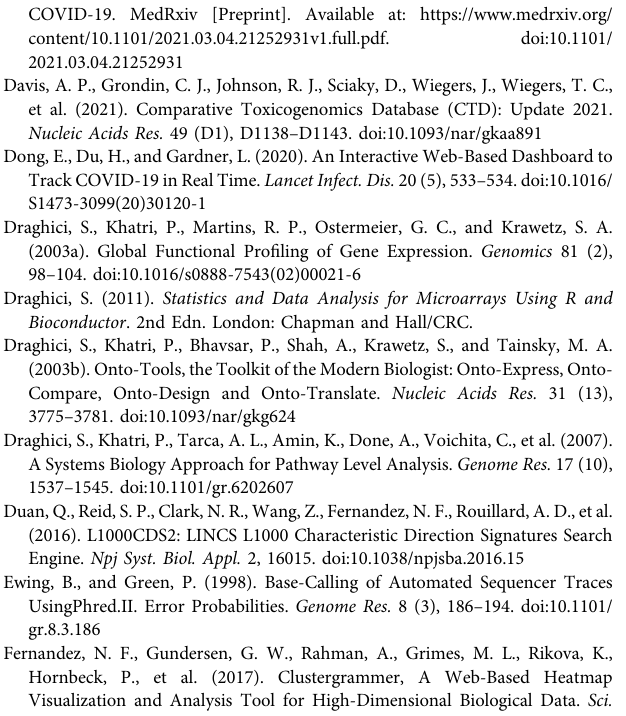
Downregulated, and Upregulated) by JQ1 using the RNK fi le generated from DEGs of Neuro-COVID vs IIH (TcMeta, DCMeta, and